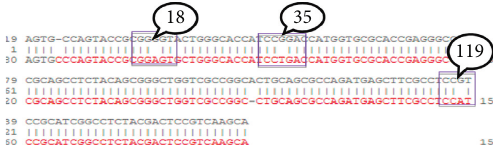
Figure 8: Position of the mutation in the UCP3